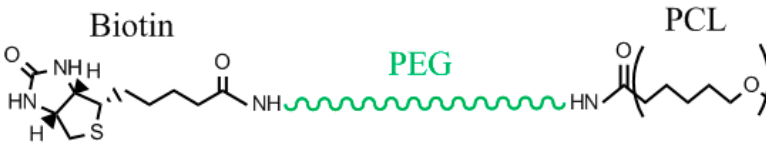
Figure 2. Chemical connectivity of PCL-PEG-Biotin nanoparticle design.